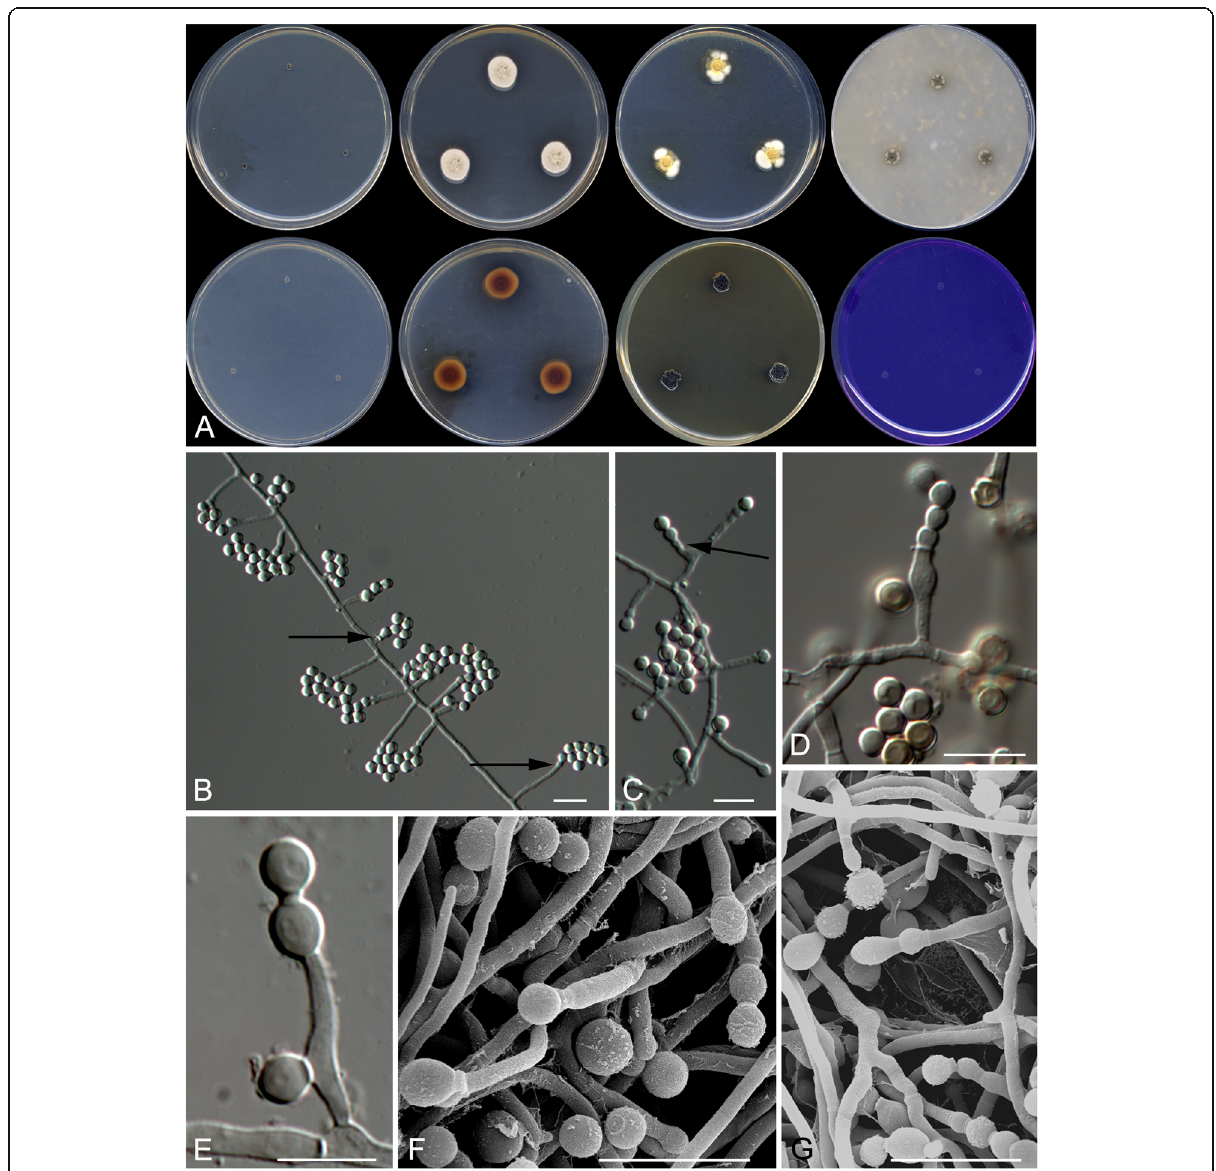
Fig. 7 Talaromyces basipetosporus CBS 143836 T . a Colonies from left to right (top row) CYA, MEA, DG18 and OA; (bottom row) CYA reverse, MEA reverse, YES and CREA. b – g Conidiophores and conidia; the arrows shows the conidia formed basipetally. Scale bar = 10 μ margins entire, yellowish grey (4B2) at the centre and white (4A1) at the edge, exudate absent, sporulation sparse; reverse brownish red (8C8) at the centre and greyish orange (5B6) at the edge, diffusible pigments ab- sent. Mycelium abundant, composed of subhyaline to pale brown, smooth to echinulate, thin-walled, septate, anasto- mosing hyphae, of 2 – 3 μ m wide. Conidiophores mostly re- duced to a single conidiogenous cell, sometimes slender and with an additional conidiogenous locus near the base, arising alternately or oppositely at both sides of the vege- tative hyphae, mostly separate from the vegetative hyphae by a basal septum. Conidiogenous cells smooth-walled to